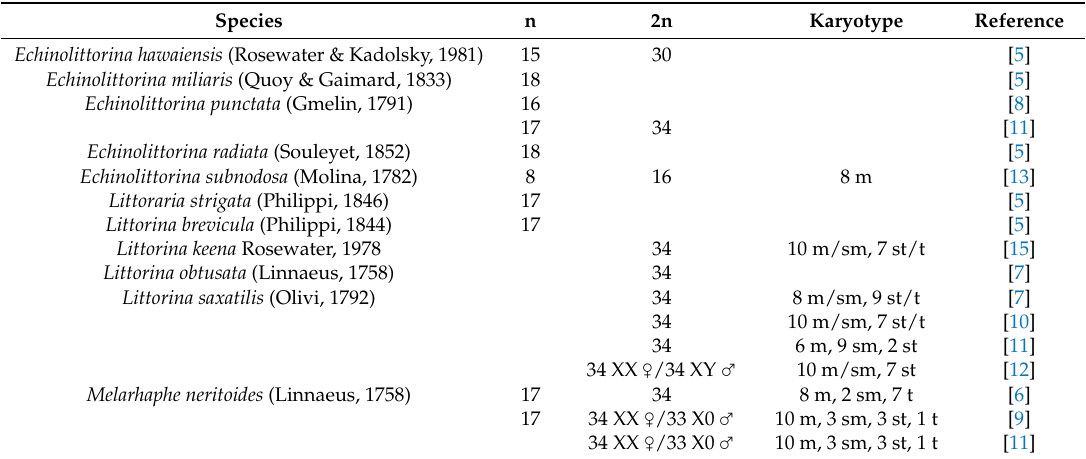
Table 1. Haploid (n) and diploid (2n) chromosome numbers and karyotypes in Littorinidae. Species n 2n Karyotype